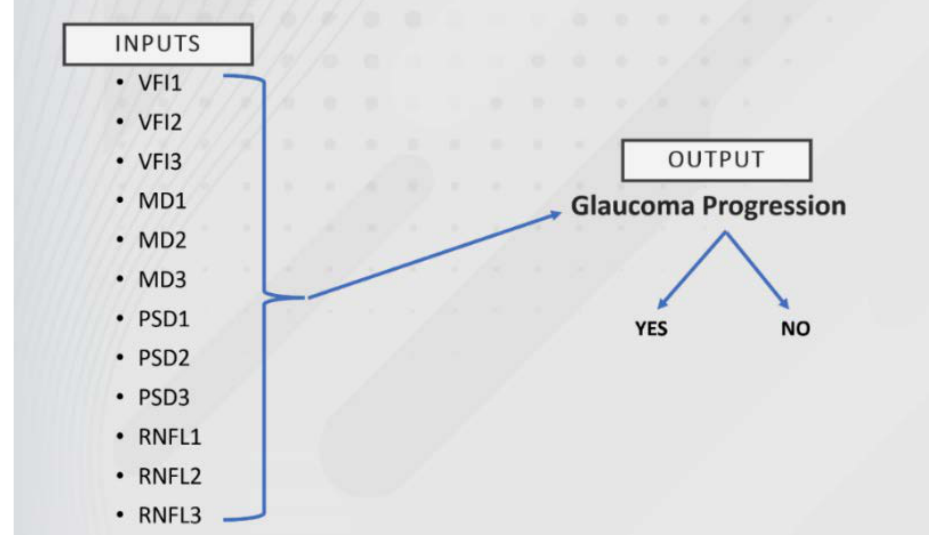
Figure 2. Selected inputs for predicting glaucoma progression for the modified dataset.